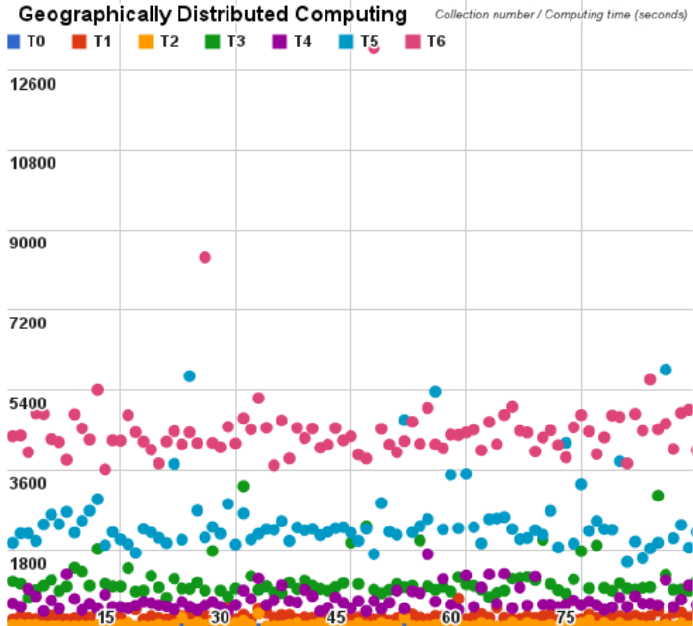
Figure 10. Geographic architecture as a dispersion